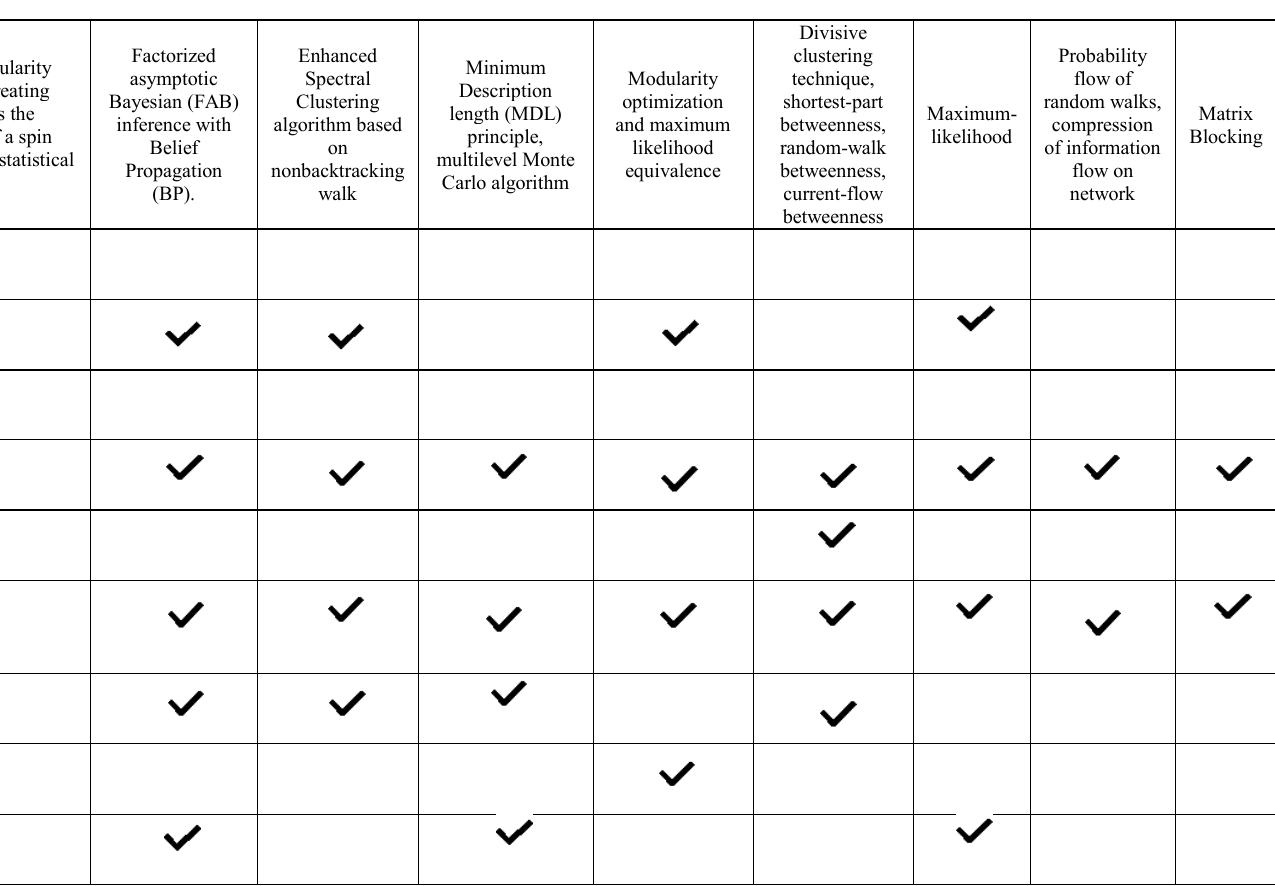
Table 2. Graphical Comparison of Community Detection